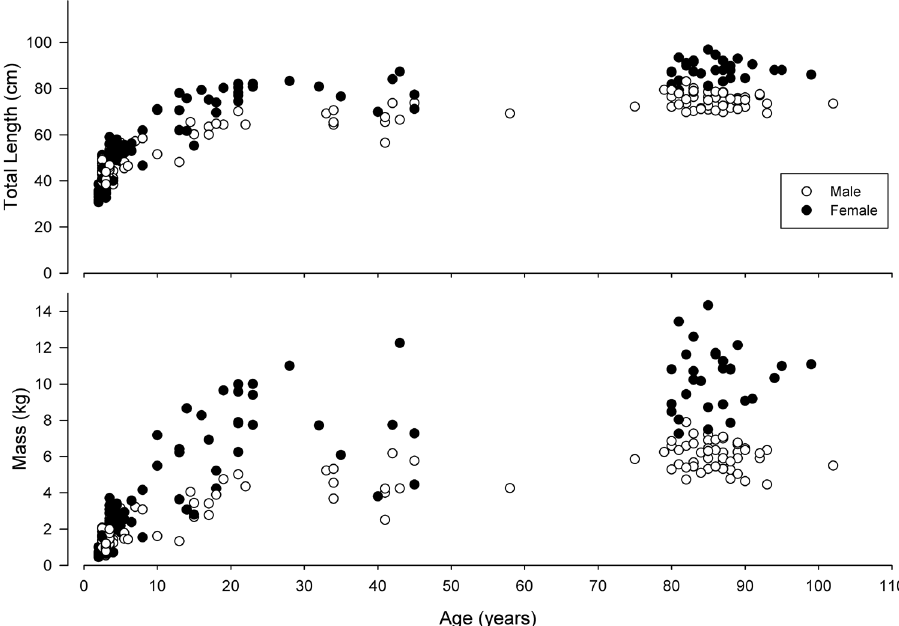
Figure 1. Age and size (total length above, mass below) of bigmouth buffalo ( Ictiobus cyprinellus ). Open circles represent males and filled circles represent